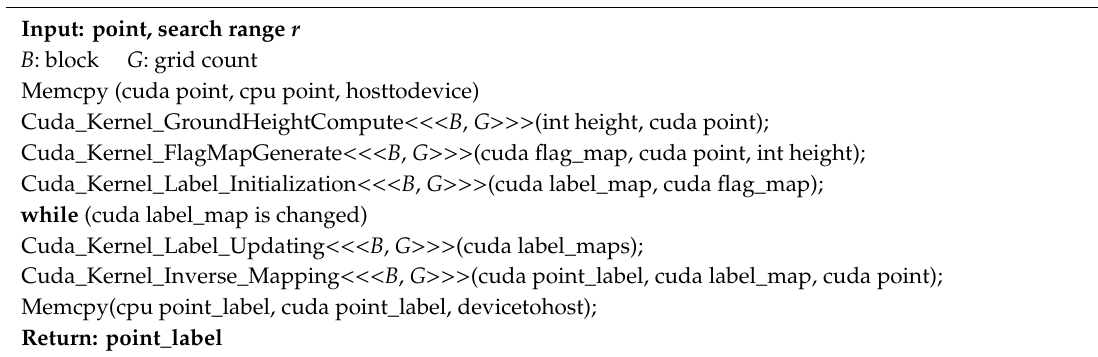
Algorithm 1: GPU-based ER-CCL